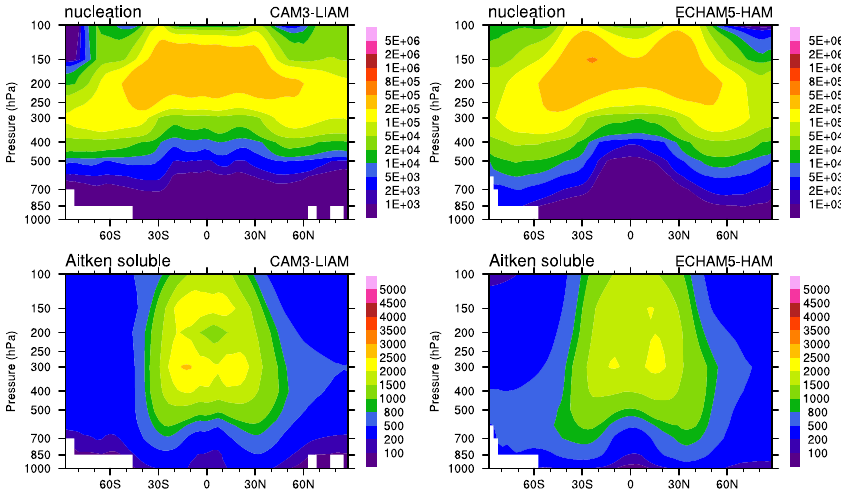
Fig. 2. Zonal and annual mean aerosol number concentrations of the nucleation mode (upper row) and Aitken soluble mode (bottom row) simulated by CAM3-LIAM (left colomn) and ECHAM5-HAM (right column) in sensitivity tests. The unit is number of particles per cubic centimeter at the standard atmospheric state (1013.25hPa, 273.15K). In the CAM3-LIAM simulation the H 2 SO 4 yields are doubled compared to the control experiment. In the ECHAM5-HAM simulation (referred to as “EXP-60P” in the text), both the H 2 SO 4 yields and the wet deposition coefficients are scaled down to 60% of the original